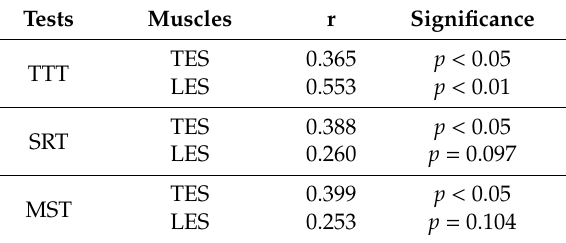
Table 7. Correlation of FRP onset index with three flexibility measurements.